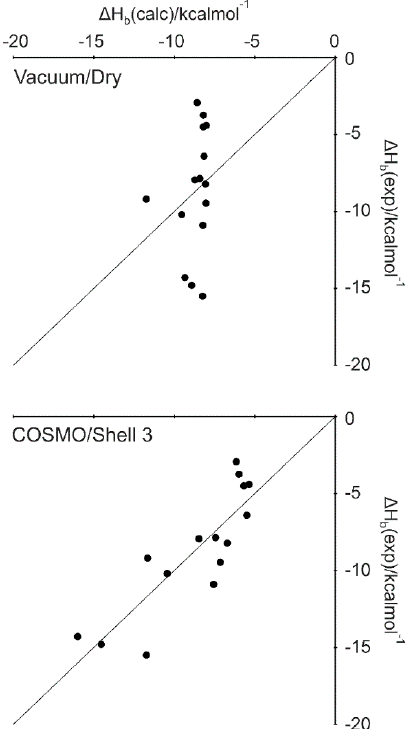
Figure 2. Correlation plots obtained without (Vacuum / Dry) and with (COSMO / Shell3) the hybrid water